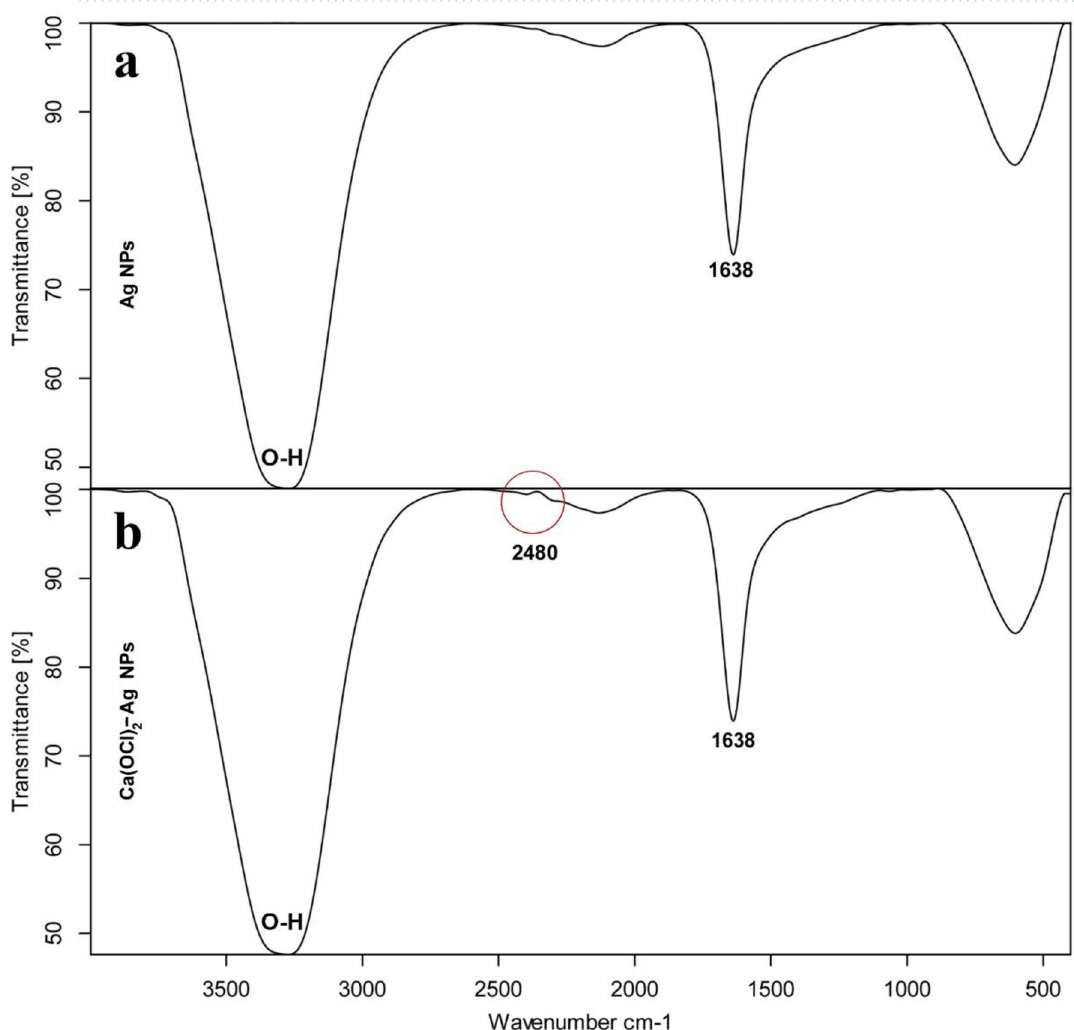
Figure 3. FT-IR spectrum of Ag NPs ( a ) and Ca(OCl) 2 -AgNPs ( b